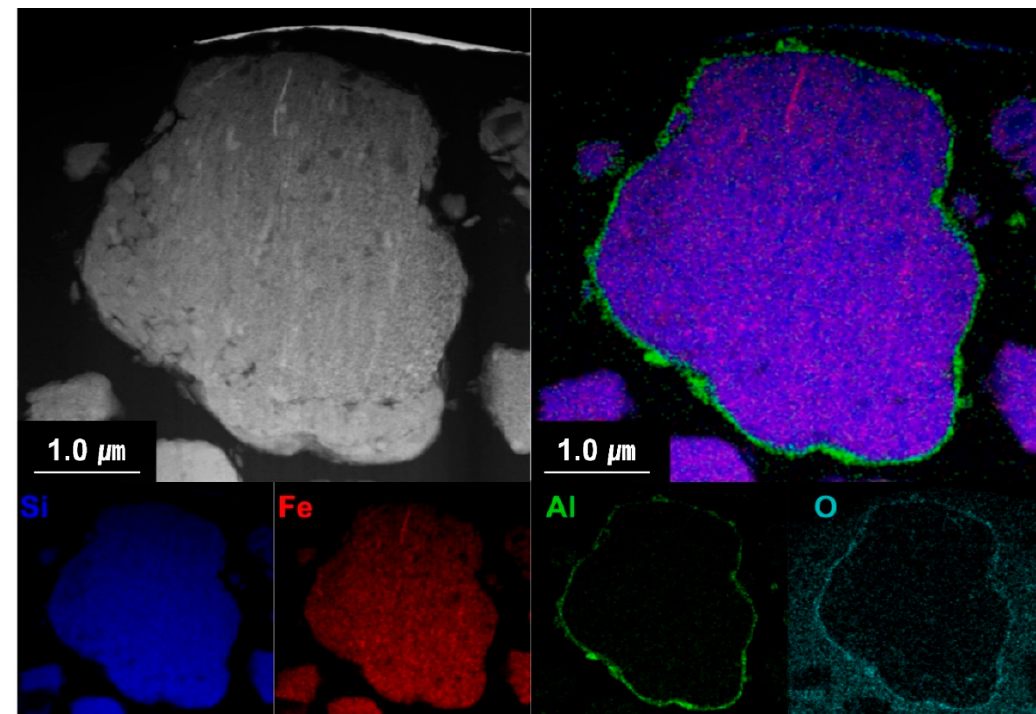
Figure 6. Cross-sectional S/TEM-EDS images of the Al 2 O 3 -2 powder.